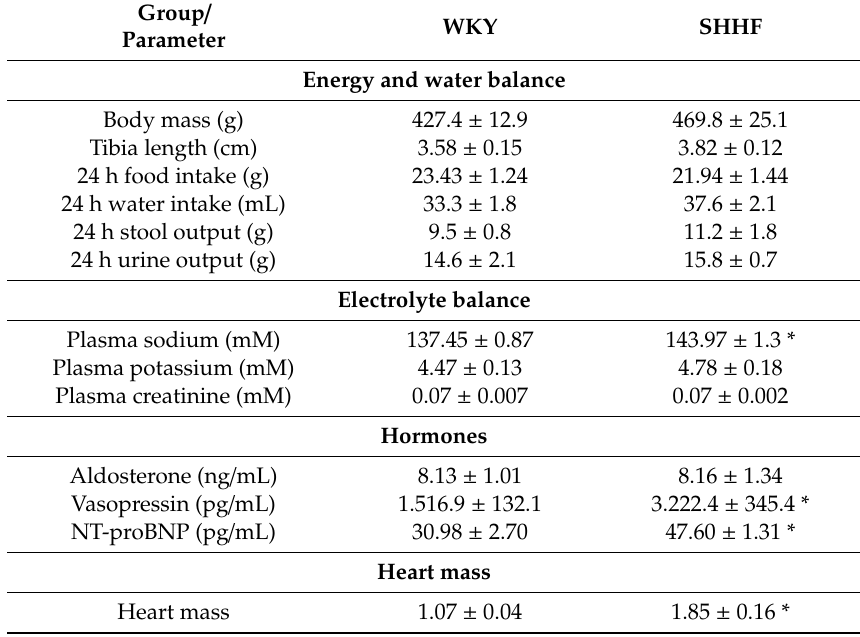
Table 1. Metabolic and cardiovascular parameters in healthy Wistar Kyoto rats (WKY), and spontaneously hypertensive heart failure rats